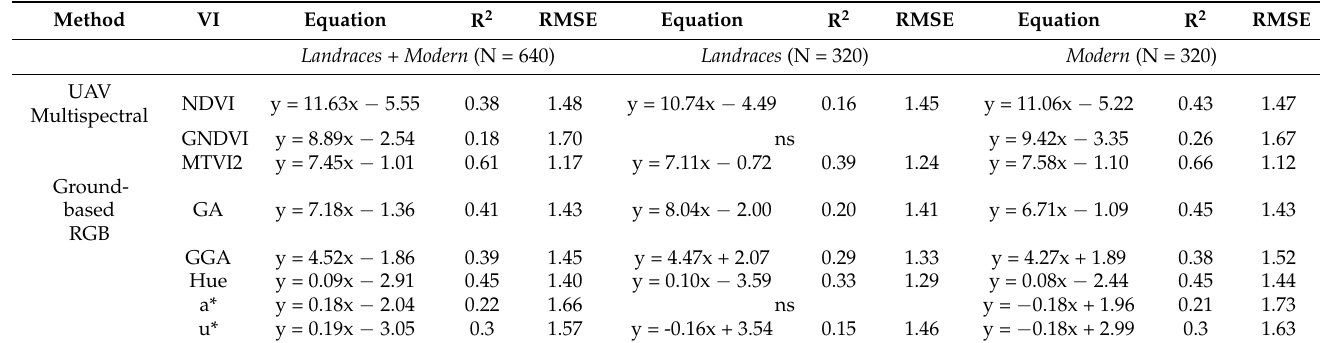
Table 6. Statistically significant ( p < 0.001) relationships between leaf area index (LAI) measured with the ceptometer and vegetation indices (VIs) obtained from UAV multispectral and RGB images. Calculations have been made with aggregated data of the two growing seasons and image acquisition occasions joining germplasm collections and for landraces and modern sets separately. ns, no significant. RMSE, root mean square